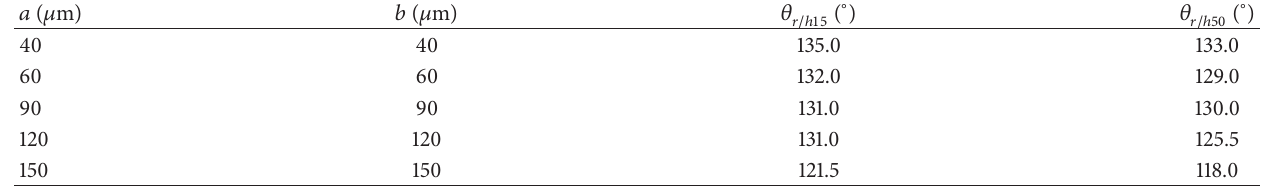
Table 2: The characteristics of prepared grooved surface: width 𝑎 , spacing 𝑏 , the measurement results of CA with 15 𝜇 m height 𝜃 𝑟/ℎ15 and 50 𝜇 m height 𝜃 𝑟/ℎ50 .